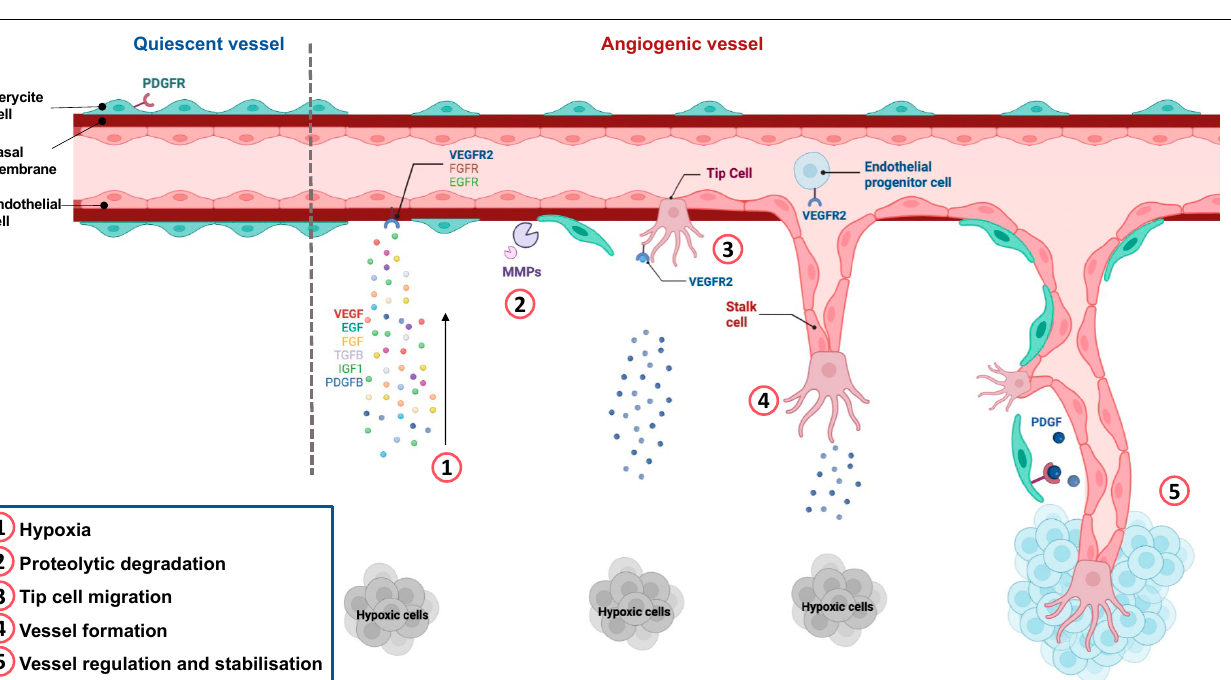
cope with the treatment and overcome the hypoxic environment